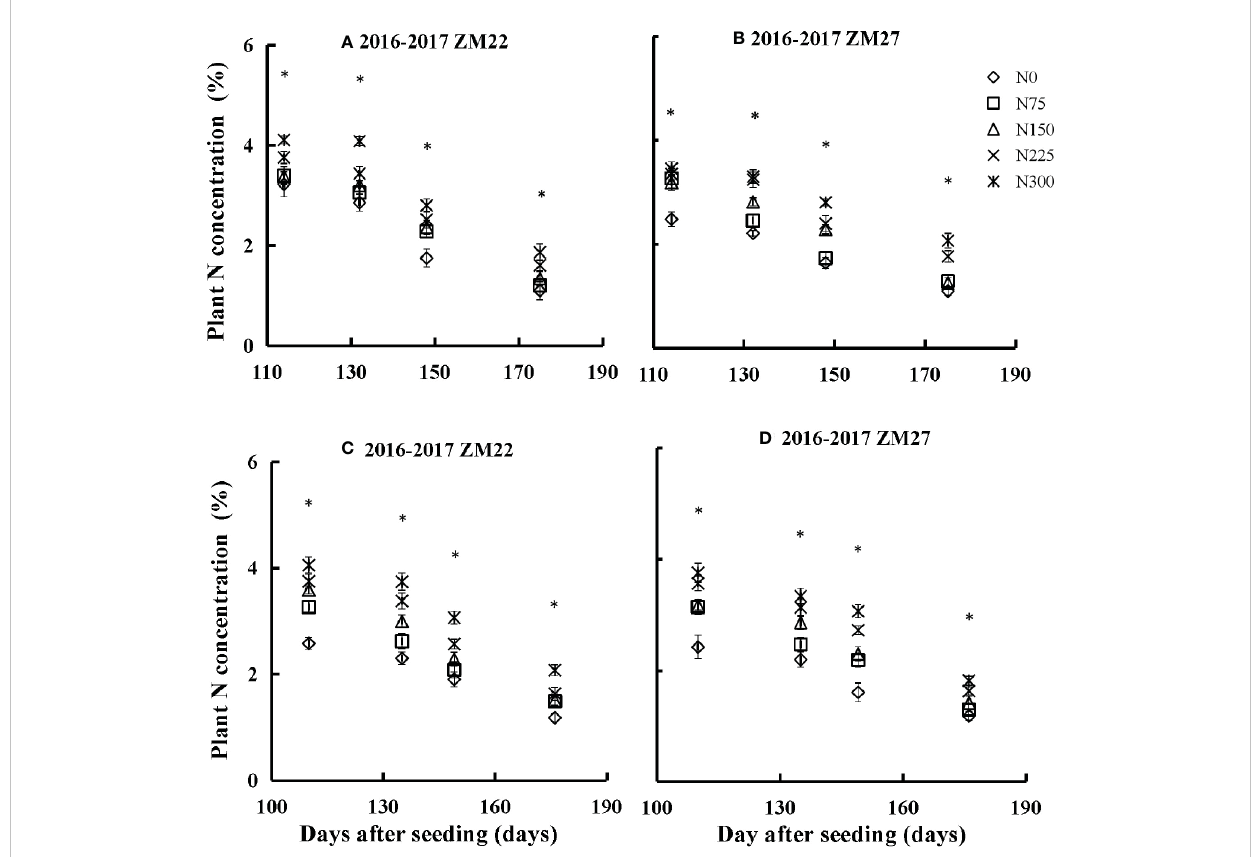
FIGURE 2 Changes in PNC as a function of time (days after sowing) at various N rates in the 2016 – 2017 seasons and for different cultivars (A, B) Xinxiang; (C, D) Jiaozuo. The vertical bar represents the standard deviation of plant N concentration, and the symbol *indicates that the p -value